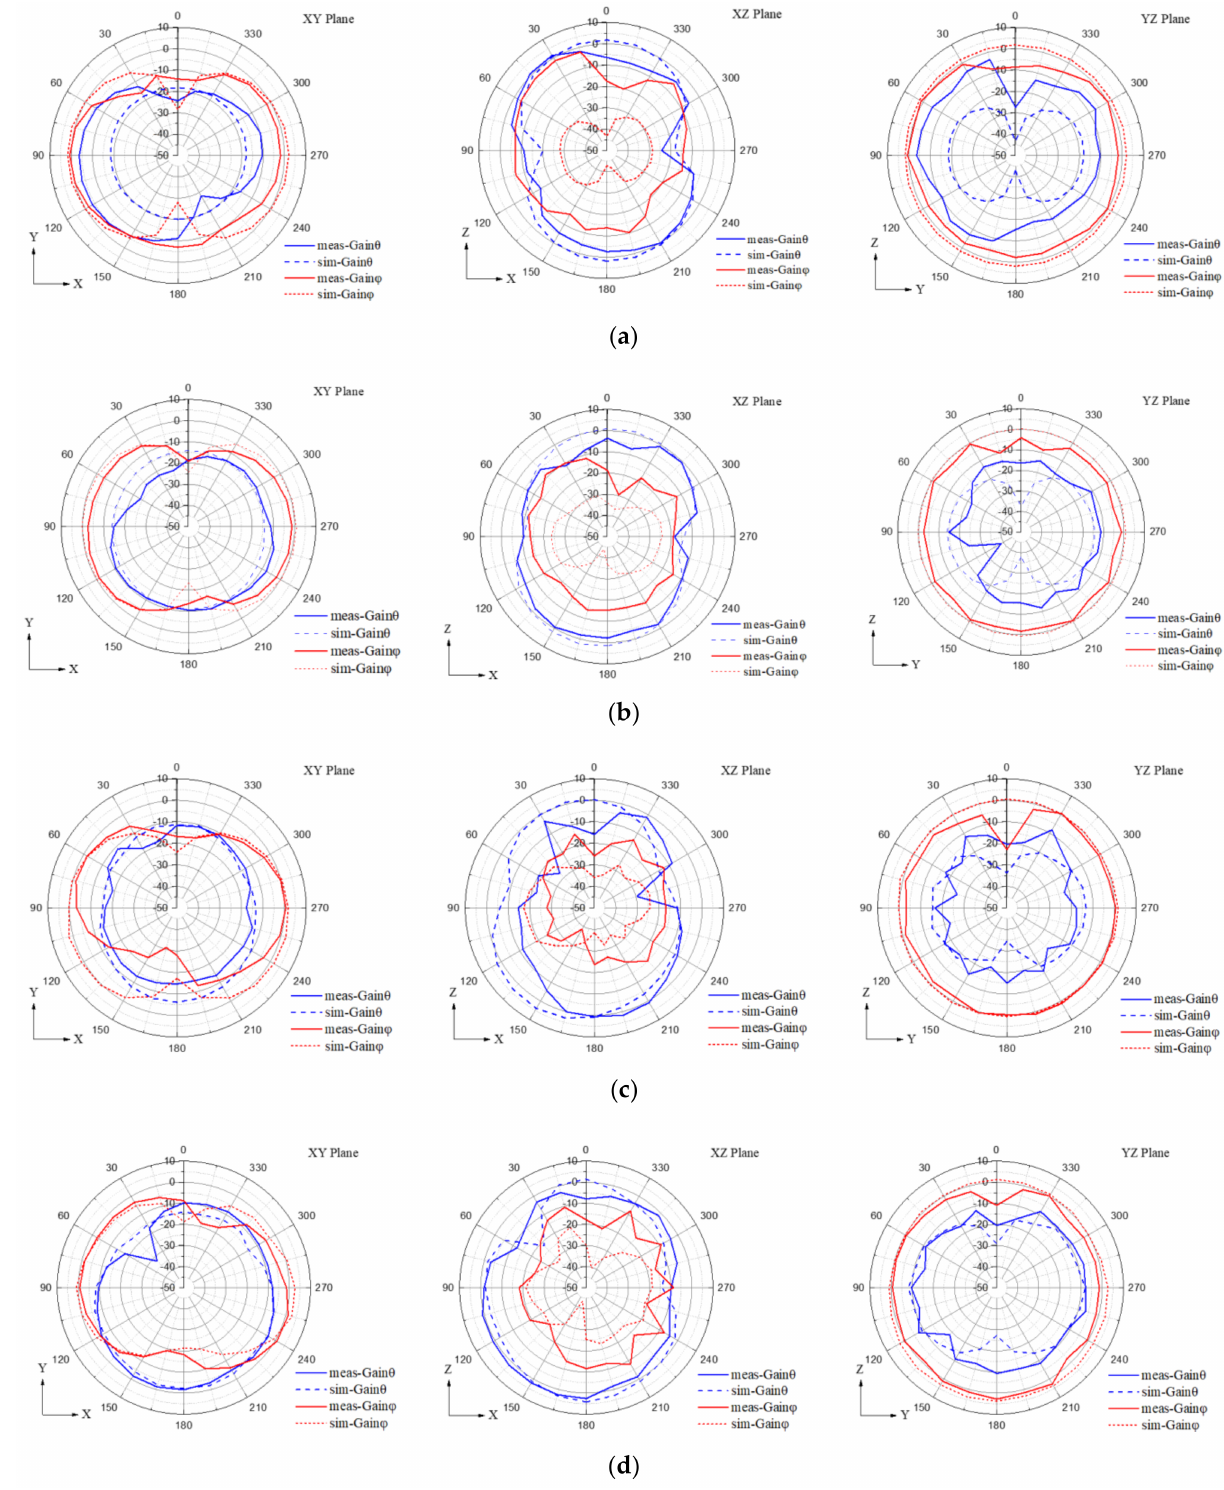
Figure 21. 2D gain simulation and measurement comparison results for Ant. 1. ( a ) 2.45 GHz; ( b ) 3.5 GHz; ( c ) 5.5 GHz; ( d ) 6.8